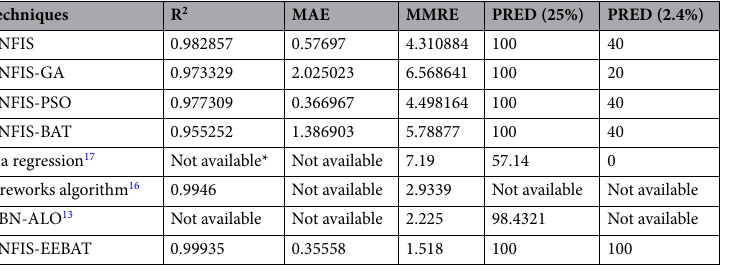
Table 9. Results on Zia with other techniques. *The data of performance metrics is not available in the referred research papers. This comparison has been performed on the real agile projects. It can be inferred that in spite of good accuracies by Fireworks optimized neural network and Deep Belief Network-Ant Lion Optimizer (DBN-ALO), a gap of actual and estimated effort is still present. This gap has been further narrowed down using ANFIS-EEBAT approach with a PRED of 100 close to 2.4%. Figure 7 depicts the Box Plot of ANFIS-EEBAT with other models.